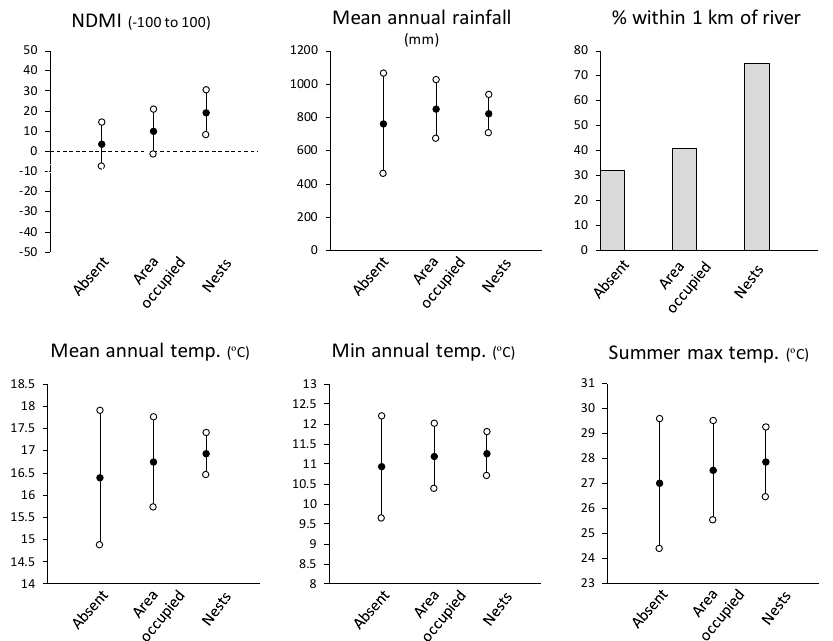
Figure 3. Comparison of means ± standard deviations for studied environmental variables between V. germanica ’s area of absence and area of occurrence and actual nest records. Distance to main rivers is a relative measurement and was instead expressed as the percentage of the area within 12 selected quarter degree grids (see methods; Figure S1), or percentage of nests, within 1 km of a main river.